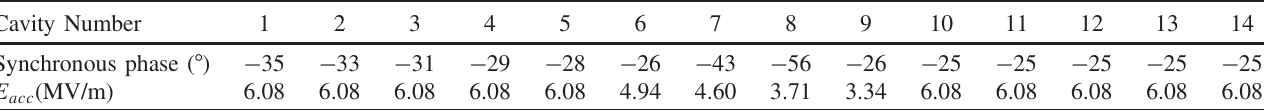
TABLE III. The design details of the Injector I SC section start from 3.2 to 10 MeV. Cavity Number